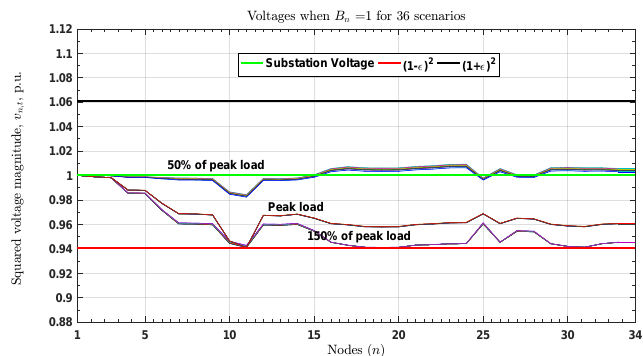
Figure 5. Voltage profile with no PV installations allowed.